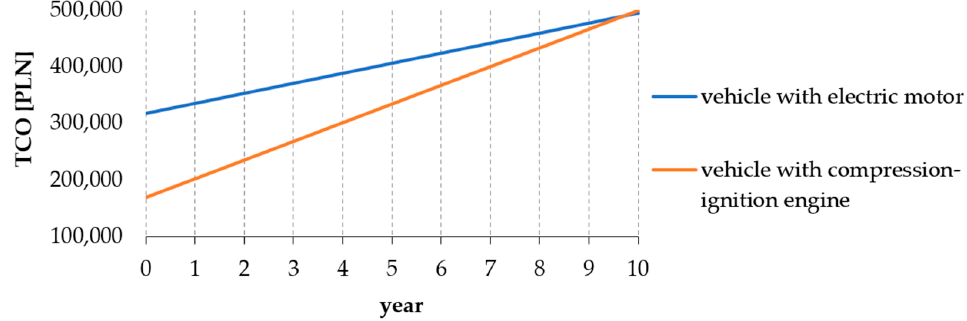
Figure 16. Total cost of ownership of vehicle during the whole operating period (vehicle is recharged only at home via an electrical socket—Scenario A1).